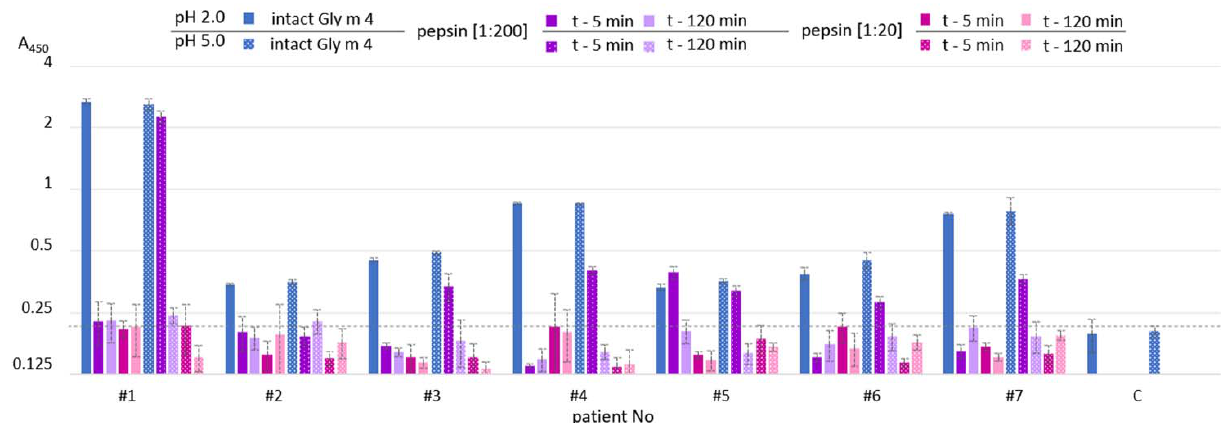
Figure 6. ELISA with the intact Gly m 4 and its gastroduodenal digests obtained at different gastric pH values (pH 2.0 (solid color) and 5.0 (pattern color)) and pepsin-to-allergen mass ratios (1:200 and 1:20) using human IgE from sera of allergic patients (t—5 min and t—120 min—time of the allergen digestion with the mixture of trypsin and α -chymotrypsin after Gly m 4 preliminary degradation by pepsin). C—the control serum from a non-allergic individual. Dotted line shows baseline absorbance corresponding to the control serum. Error bars represent standard deviation between technical replications.